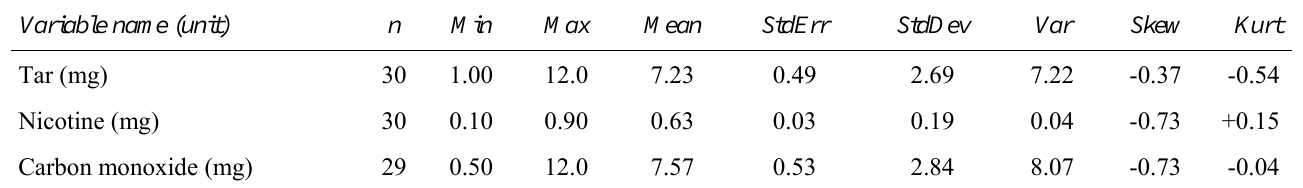
Table 2: Cigarette chemical composition: descriptive